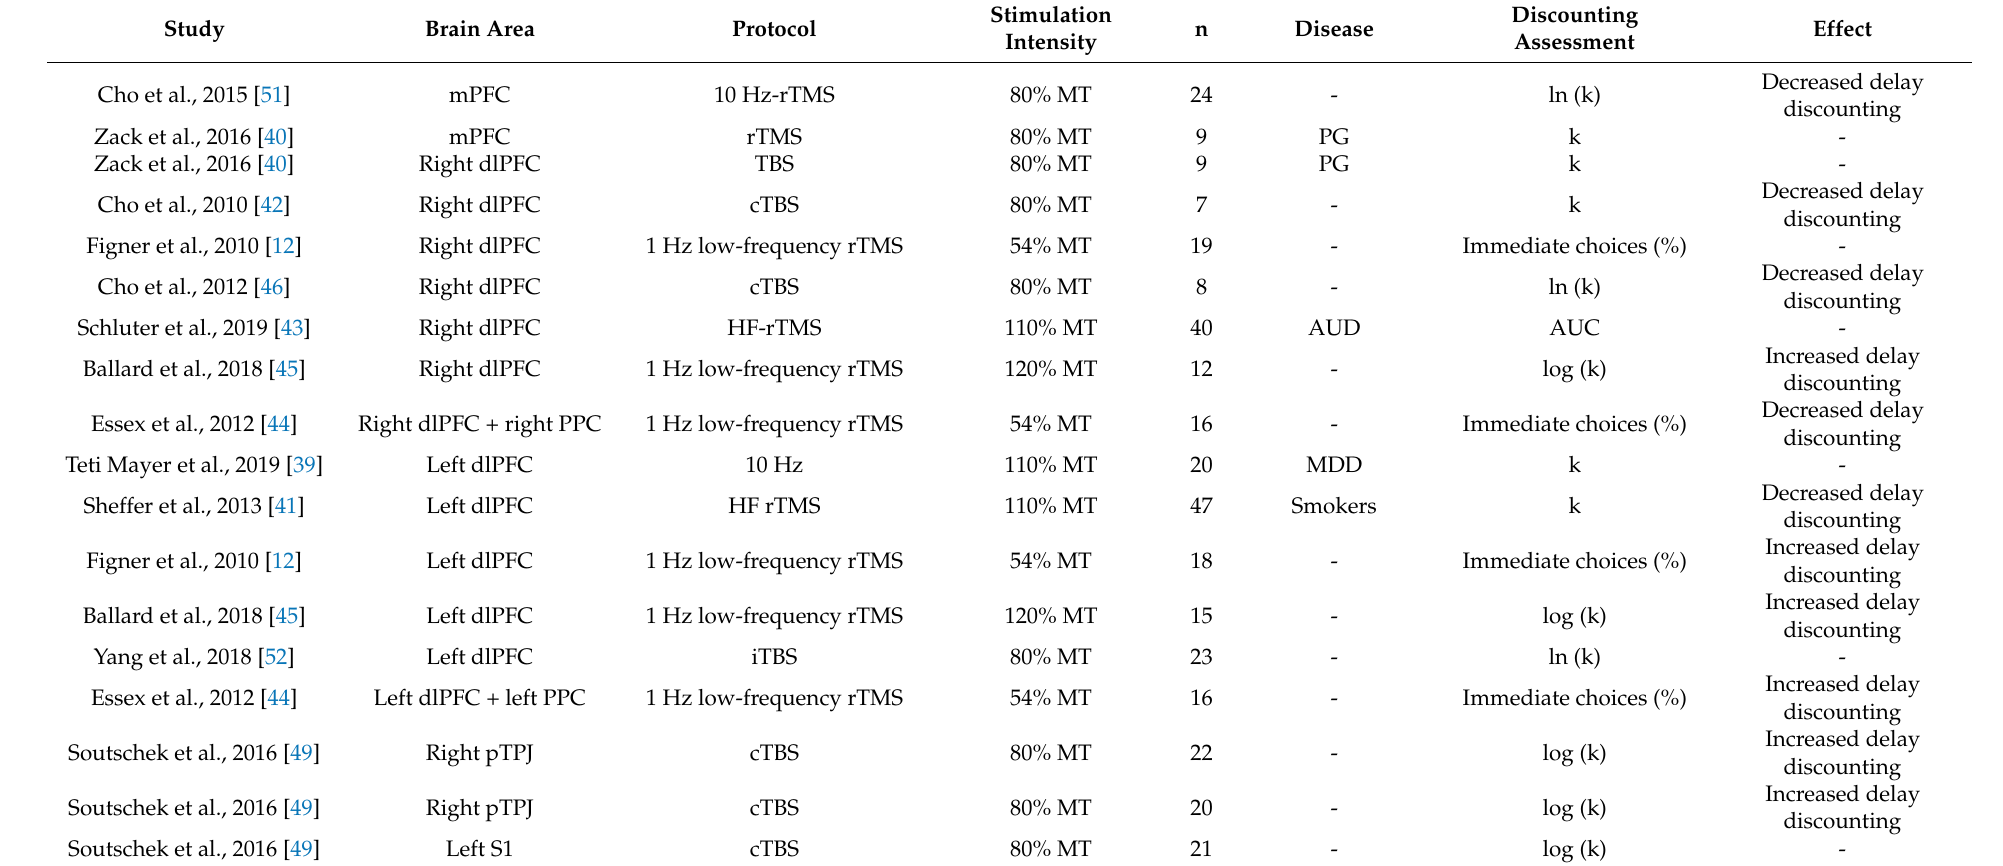
Table 1. Studies investigating delay discounting performance modulation by TMS. MDD = major depression disorder; PG = pathological gambling; AUD = alcohol use disorder; MT = motor